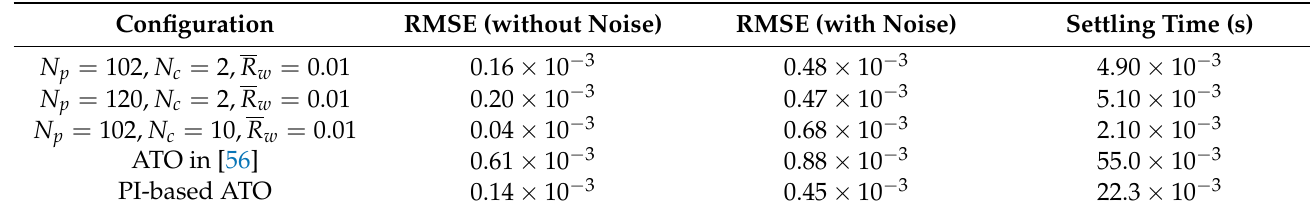
Table 3. RMSE and settling time in the simulation tests.